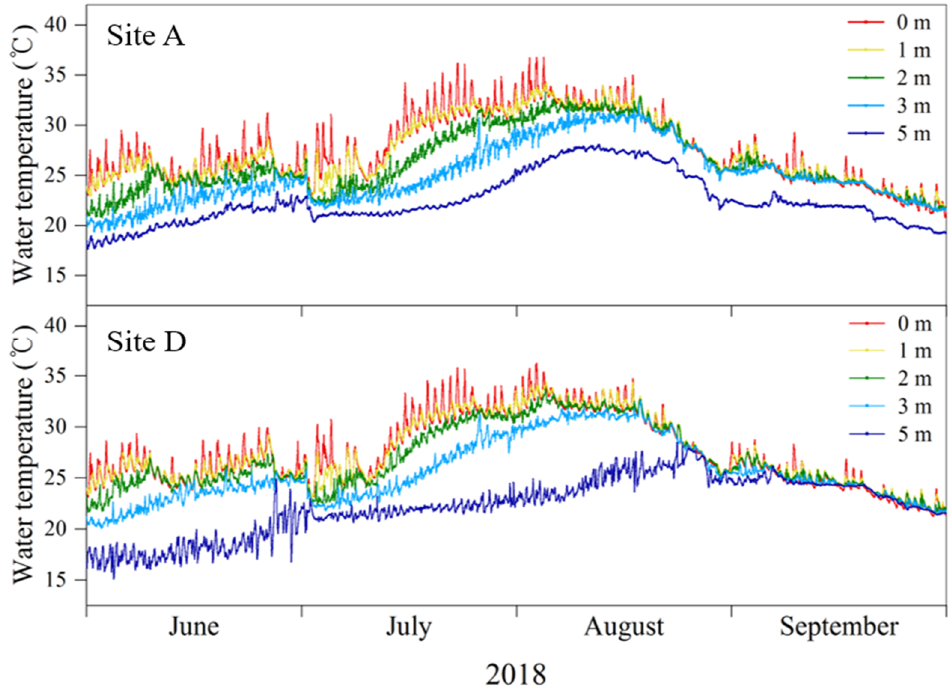
Figure 5. Changes in water temperature with depth in 2018 at (A) the CWCS deployment site and (D) the natural circulation site (200 m away from site A).